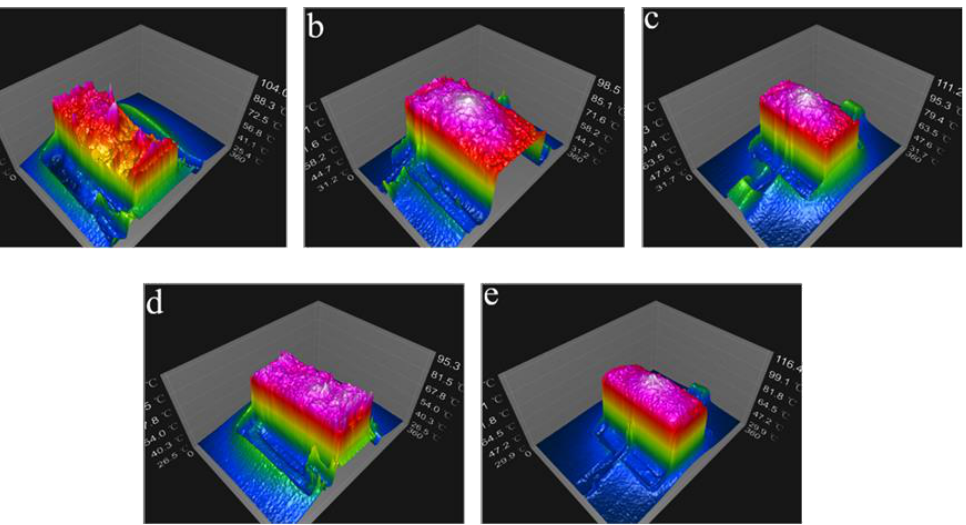
Figure 8. The 3D model of surface temperature distribution of AgNWs-TCFs. ( a ) The bare AgNWs-TCFs, ( b ) AgNWs@TiO 2 -TCFs, ( c ) AgNWs@Al 2 O 3 -TCFs, ( d ) AgNWs@ZnO-TCFs, ( e ) AgNWs@SnO 2 -TCFs.